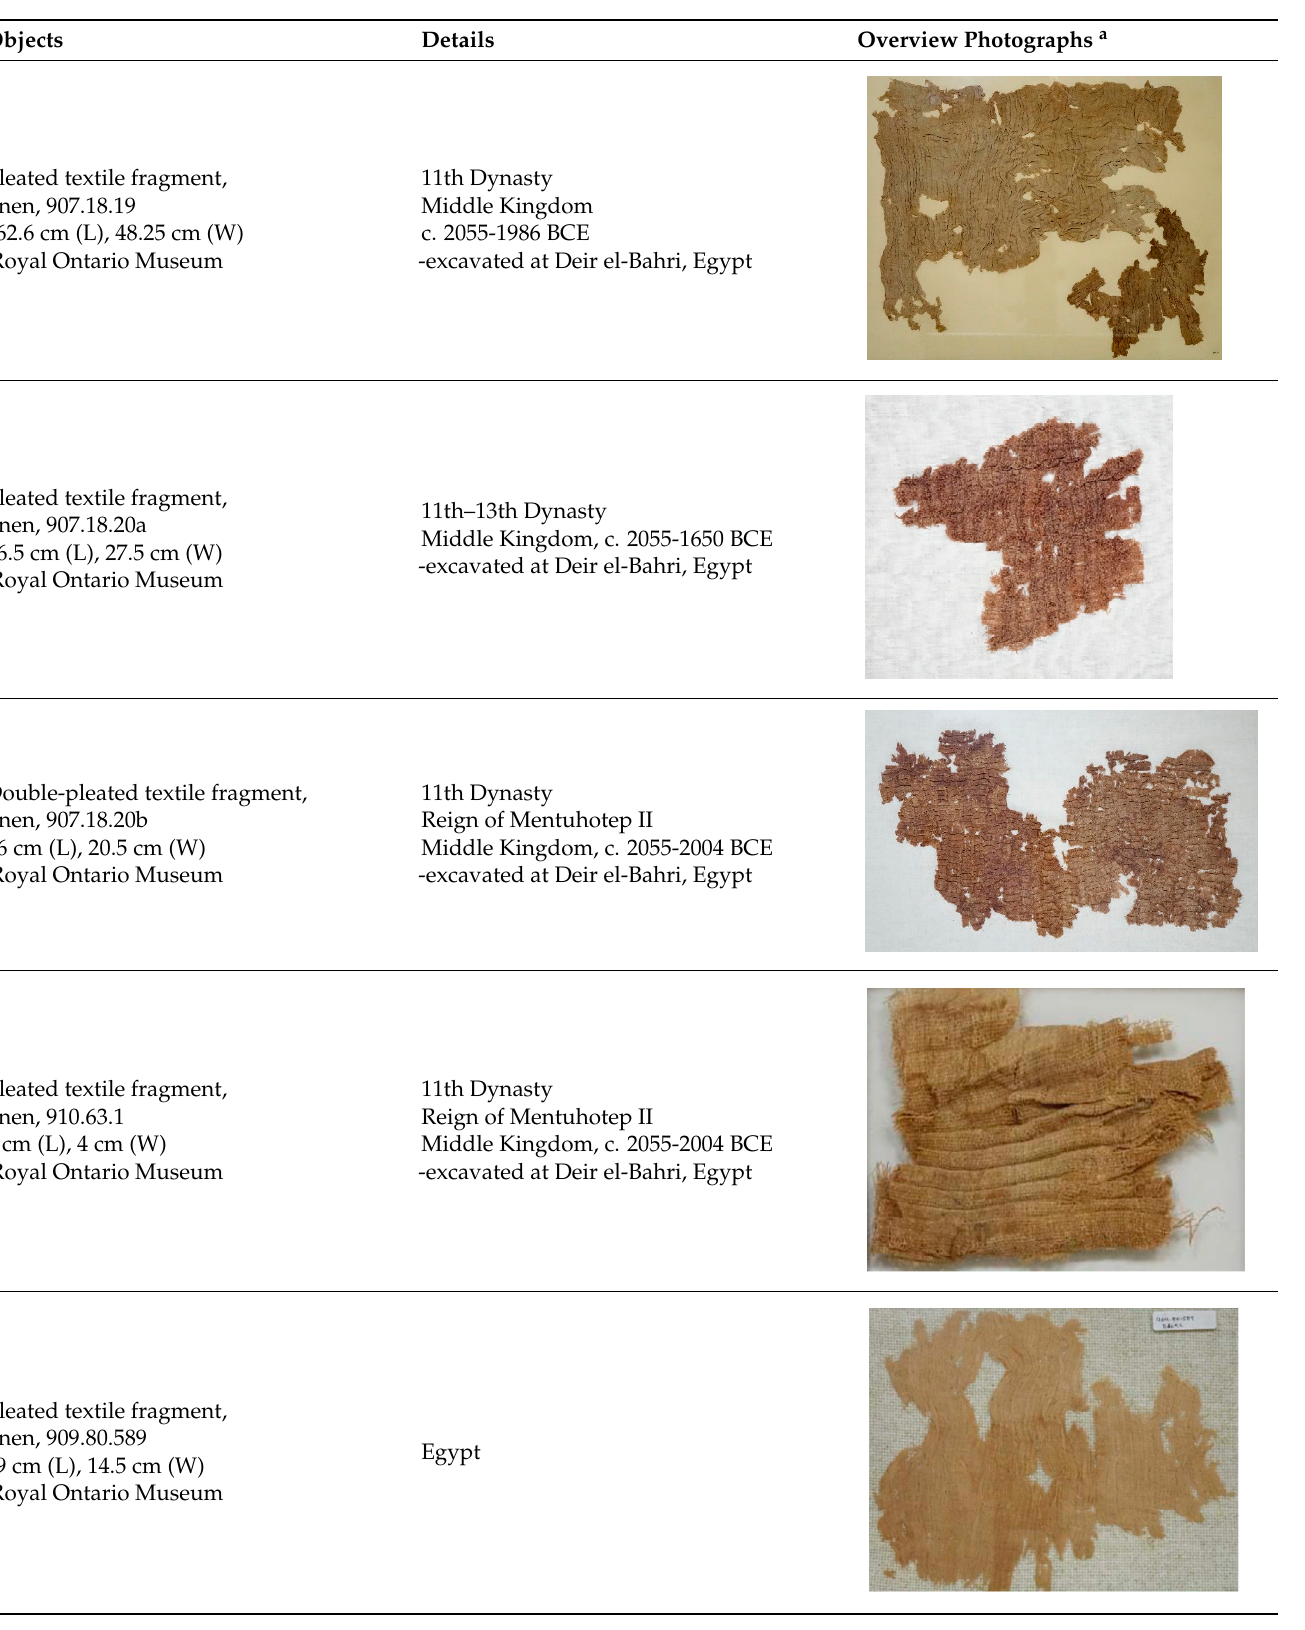
Table 4. Objects